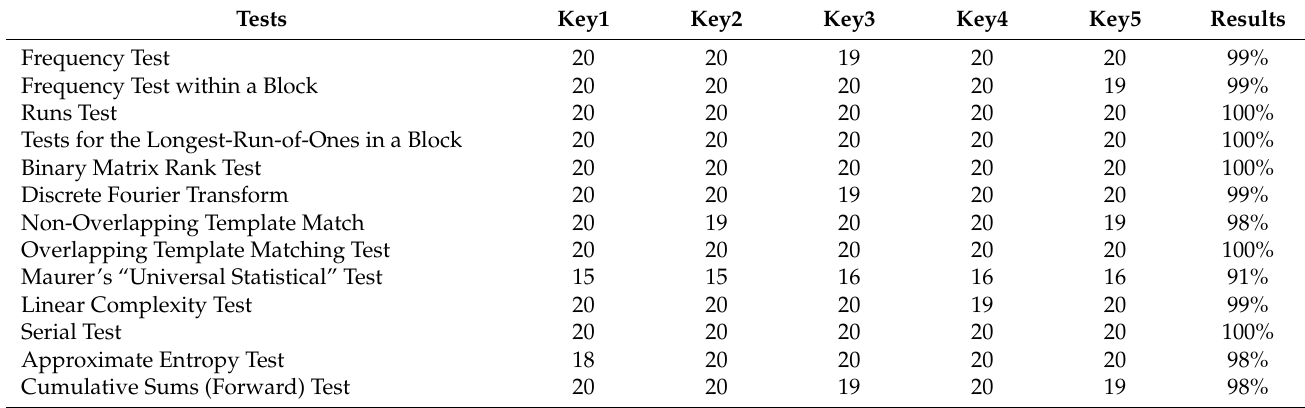
Table 8. Results of statistical tests from the NIST-822 STS